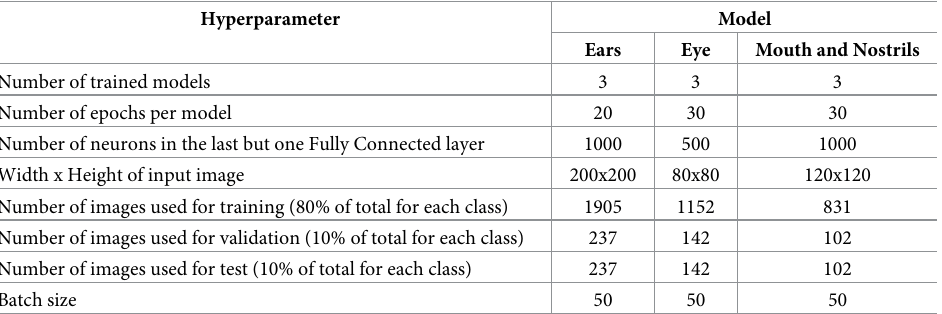
Table 3. Hyperparameters used in the final classifier model for each evaluated parameter (ears, eye, and mouth and nostrils). Hyperparameter